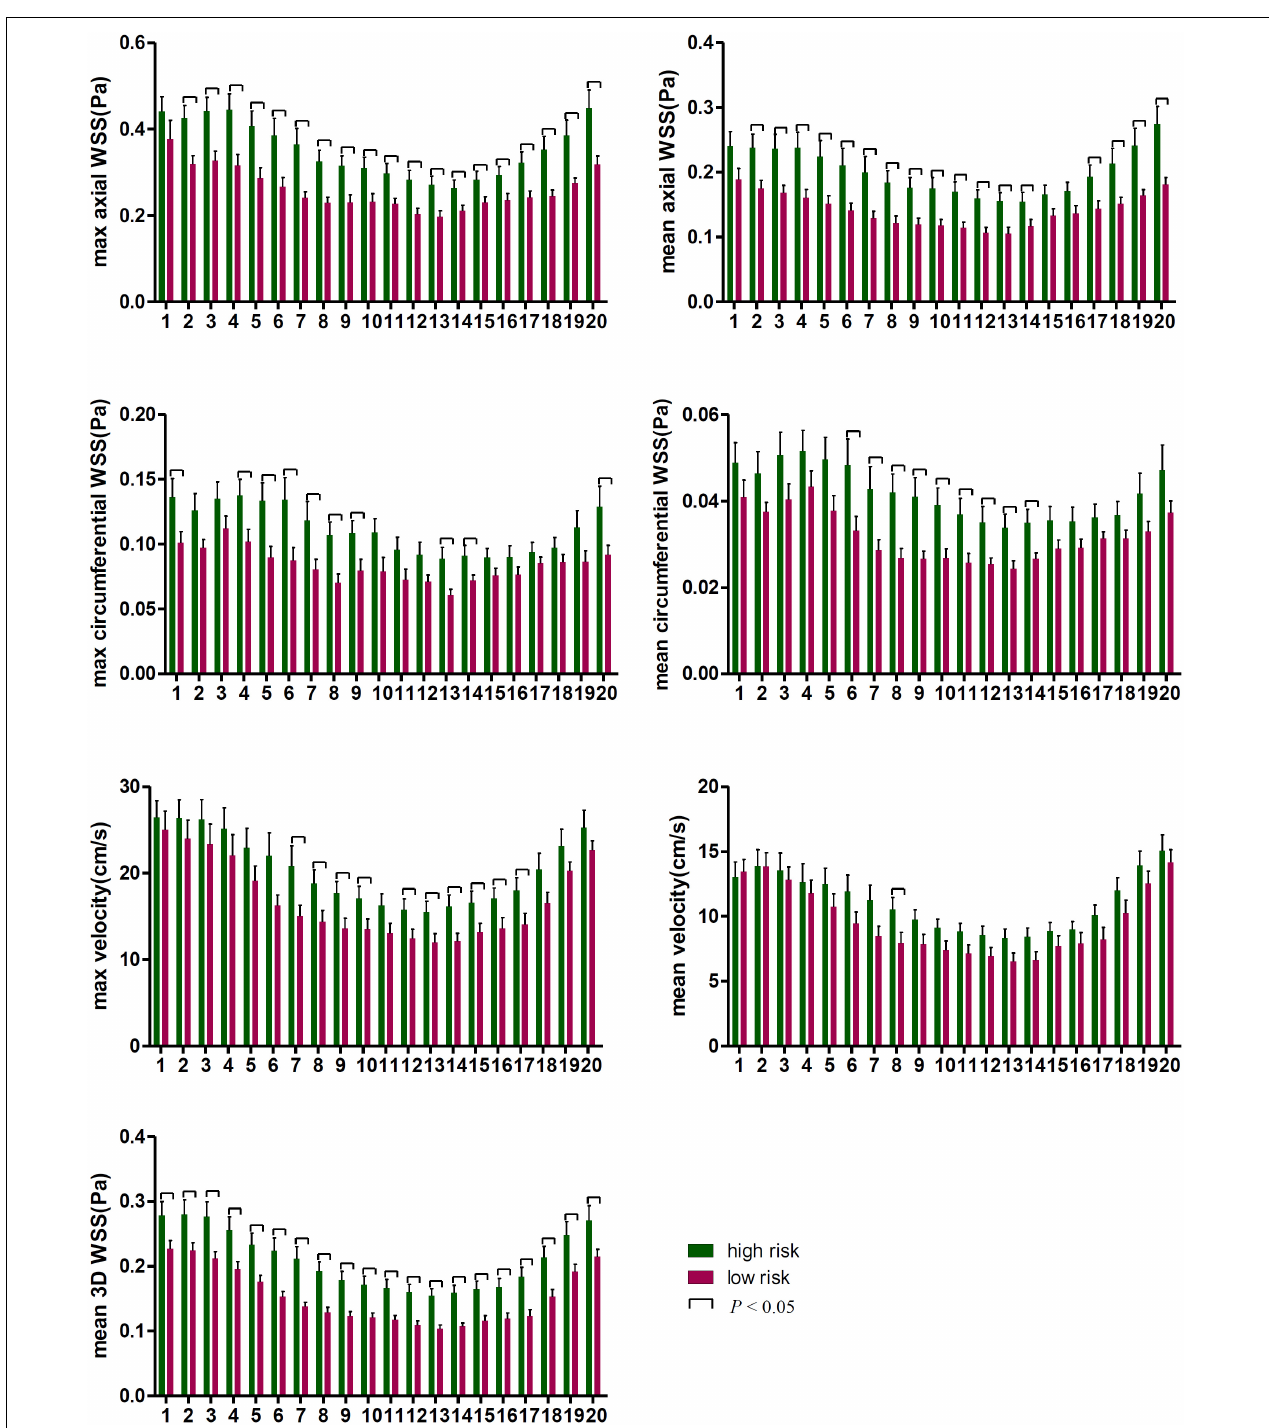
FIGURE 5 | The WSS differences at every time point in the cardiac cycle. The first time point was the start of the rapid ejection period, with 1–5 time points and 16–20 time points representing systole and 6–15 time points representing diastole.